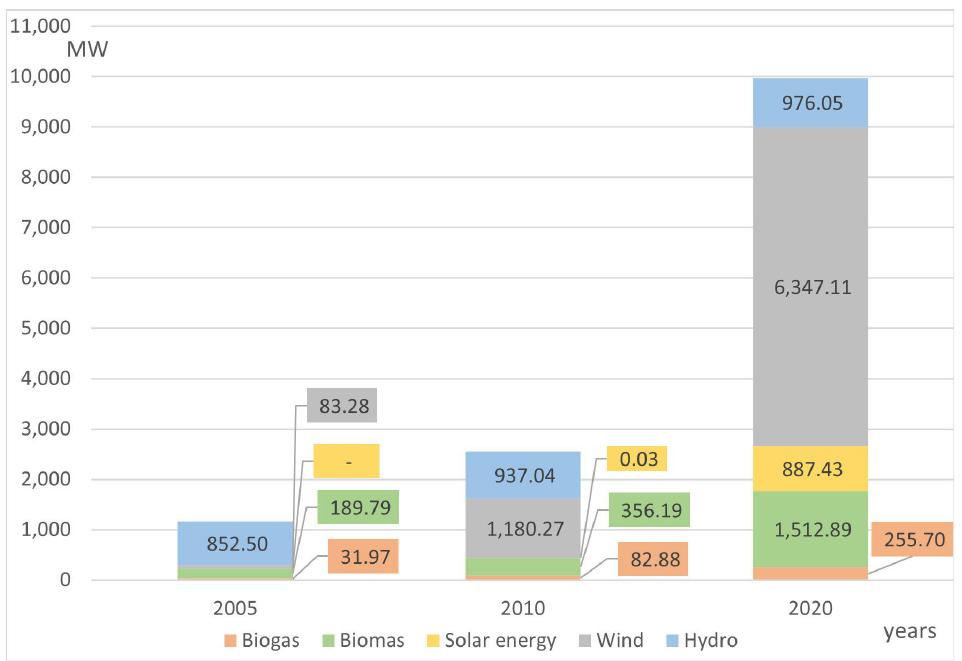
Figure 6. Share of RES in final gross electricity energy consumption in the EU and Poland (%). * 2019 for EU. Source: Energy. Statistical Yearbook, SP.